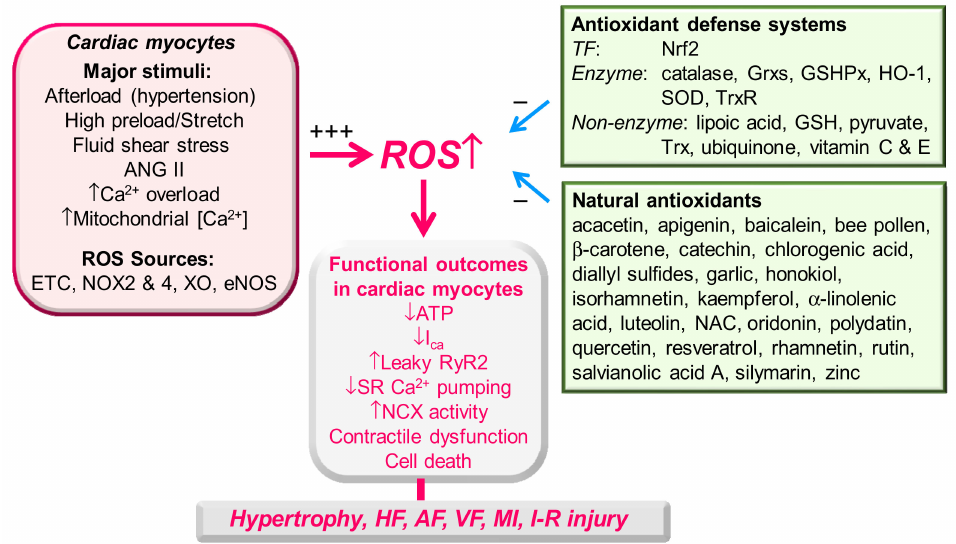
Figure 1. Effective substances and mechanisms to decrease or increase ROS level and functional outcomes of redox unbalance in cardiac myocytes and heart. Redox unbalances by overproduction of ROS via fewer antioxidants or excess ROS-producing stimuli may result in dysregulation of Ca 2+ signaling and metabolism (“functional outcomes”) and are associated with the pathogenesis of cardiac diseases. ETC., electron transport chain; NCX, Na + –Ca 2+ exchanger; XO, xanthine